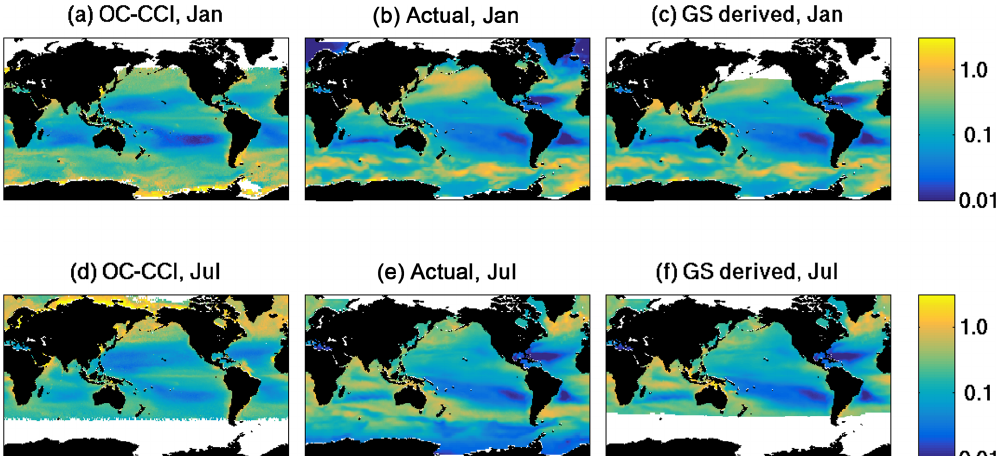
Figure 1. Chl a (mgm − 3 ). (a) and (d) OC-CCI-derived, (b) and (e) default model “actual” 0–50m (summed over the nine phytoplankton types), (c) and (f) default model “derived” (calculated from reflectance ratio and satellite-like algorithm trained with subsampled dataset, GS). Top row shows January climatological means and bottom row shows July climatological means. OC-CCI products (a, d) have no data when irradiances are too low. The model does not resolve the Arctic and thus there is no output there in (b) , (c) , (e) , and (f) . Additional lack of output in (c) and (f) indicates regions where PAR is less than 15µEinm − 2 s − 1 . OC-CCI products were downloaded from https: //www.oceancolour.org. We use version 2 of the OC-CCI, which uses an OC4 algorithm for determining the Chl a product, and thus is a comparable algorithm as used in our model derived Chl a shown in (c) and (f) .